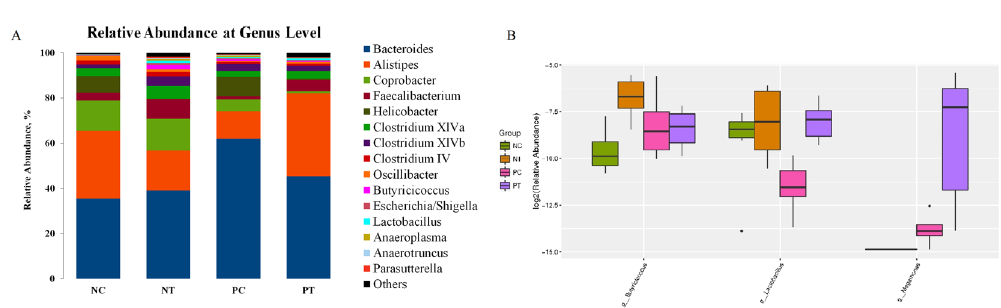
Figure 9. Effect of dietary E . faecium 11181 on the taxonomic composition of cecal microbiota in broiler chickens challenged with NE at d 26 (n = 6). ( A ) Relative abundance of the top 15 microorganisms at the genus level. ( B ) Different abundances at genus levels. NC = Non-NE-infected + no E. faecium treatment, NT = non- NE-infected + E. faecium treatment, PC = NE-infected + no E. faecium treatment, PT = NE-infected + E. faecium